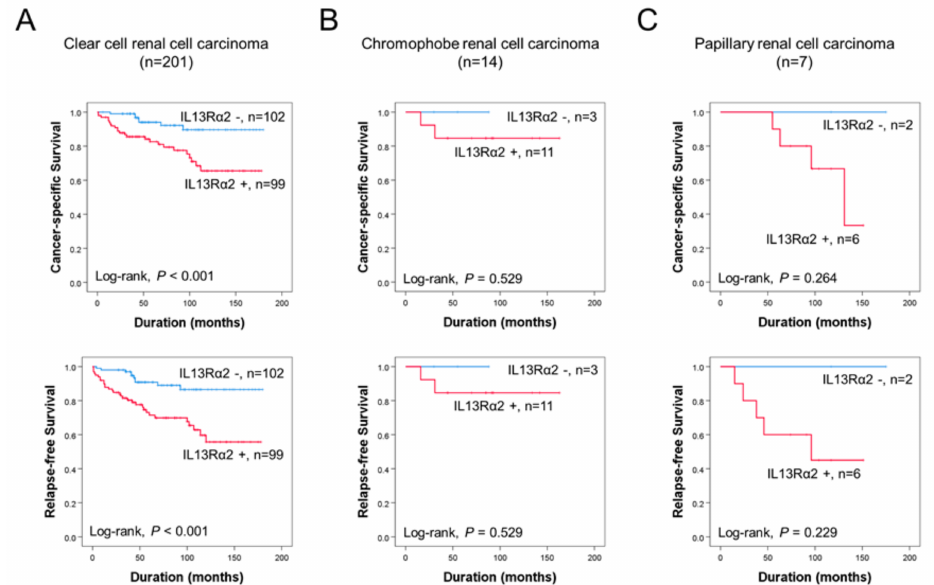
Figure 2. Kaplan–Meier survival analysis in histologic subtypes of renal cell carcinomas. Kaplan– Meier survival curves for cancer-specific survival (CSS) and relapse-free survival (RFS) according to the expression of IL13R α 2 in clear cell renal cell carcinoma ( A ), chromophobe renal cell carcinoma ( B ), and papillary renal cell carcinoma ( C